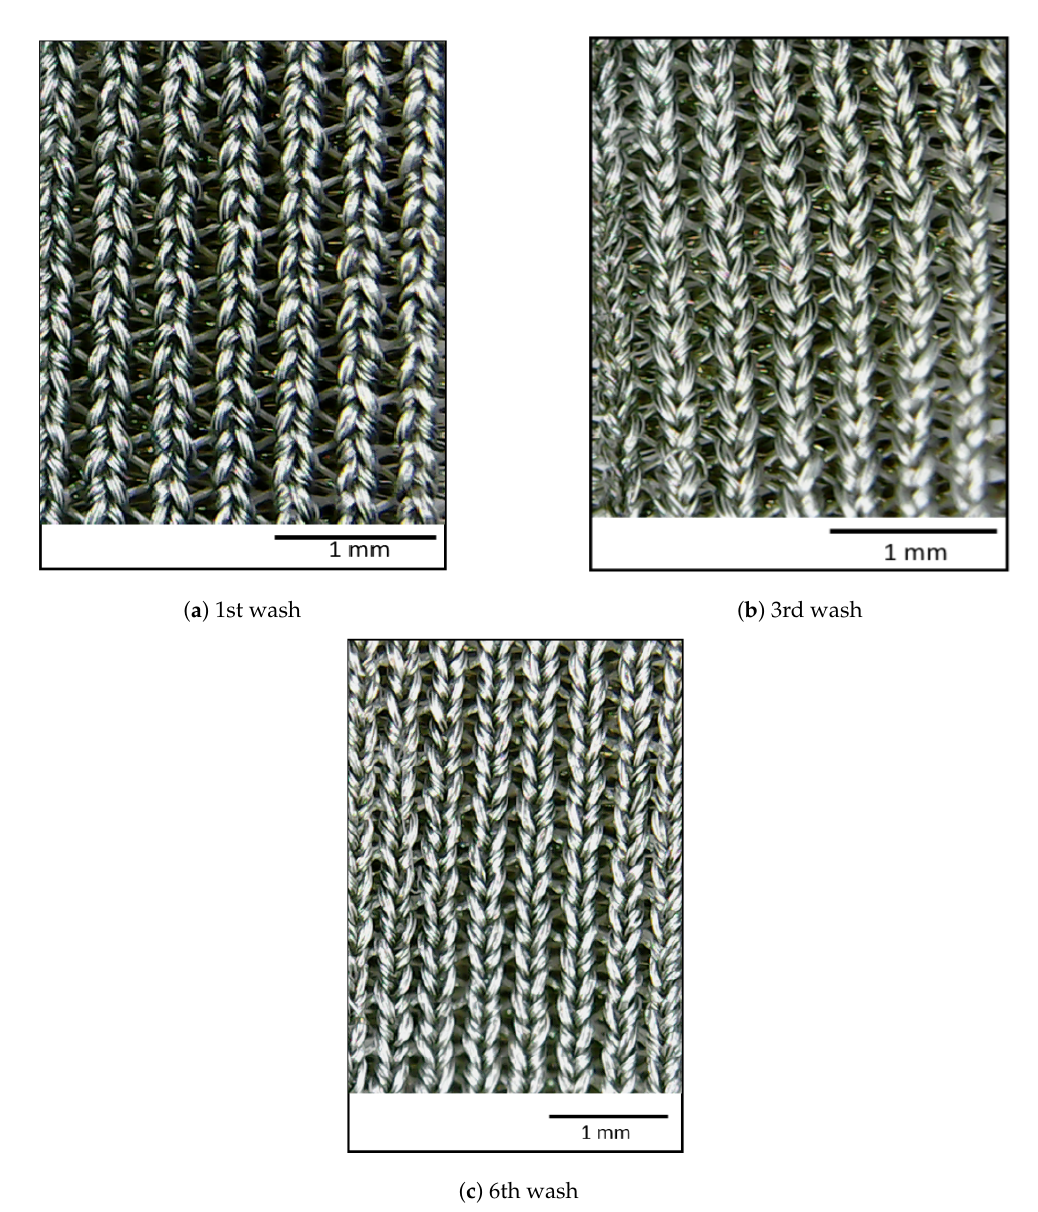
Figure A1. Front side microscopic figures after 1st, 3rd and 6th wash